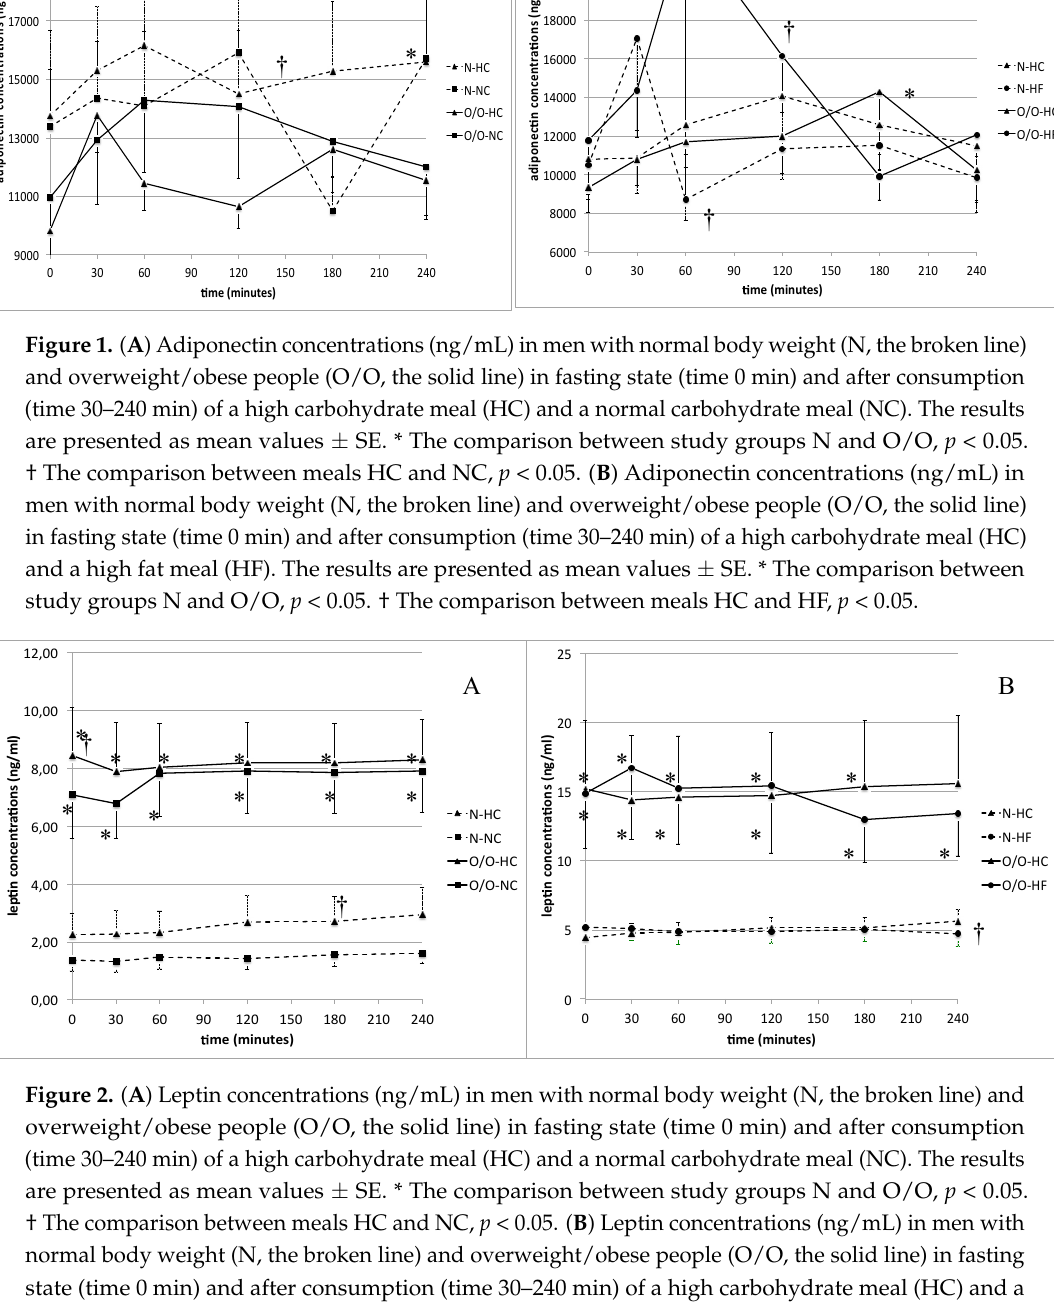
Figure 2. ( A ) Leptin concentrations (ng/mL) in men with normal body weight (N, the broken line) and overweight/obese people (O/O, the solid line) in fasting state (time 0 min) and after consumption (time 30–240 min) of a high carbohydrate meal (HC) and a normal carbohydrate meal (NC). The results are presented as mean values ± SE. * The comparison between study groups N and O/O, p < 0.05. † The comparison between meals HC and NC, p < 0.05. ( B ) Leptin concentrations (ng/mL) in men with normal body weight (N, the broken line) and overweight/obese people (O/O, the solid line) in fasting state (time 0 min) and after consumption (time 30 – 240 min) of a high carbohydrate meal (HC) and a high fat meal (HF). The results are presented as mean values ± SE. * The comparison between study groups N and O/O *p < 0.05. † The comparison between meals HC and HF p < 0.05. The total ghrelin concentration analysis in Group I showed that there were not any significant